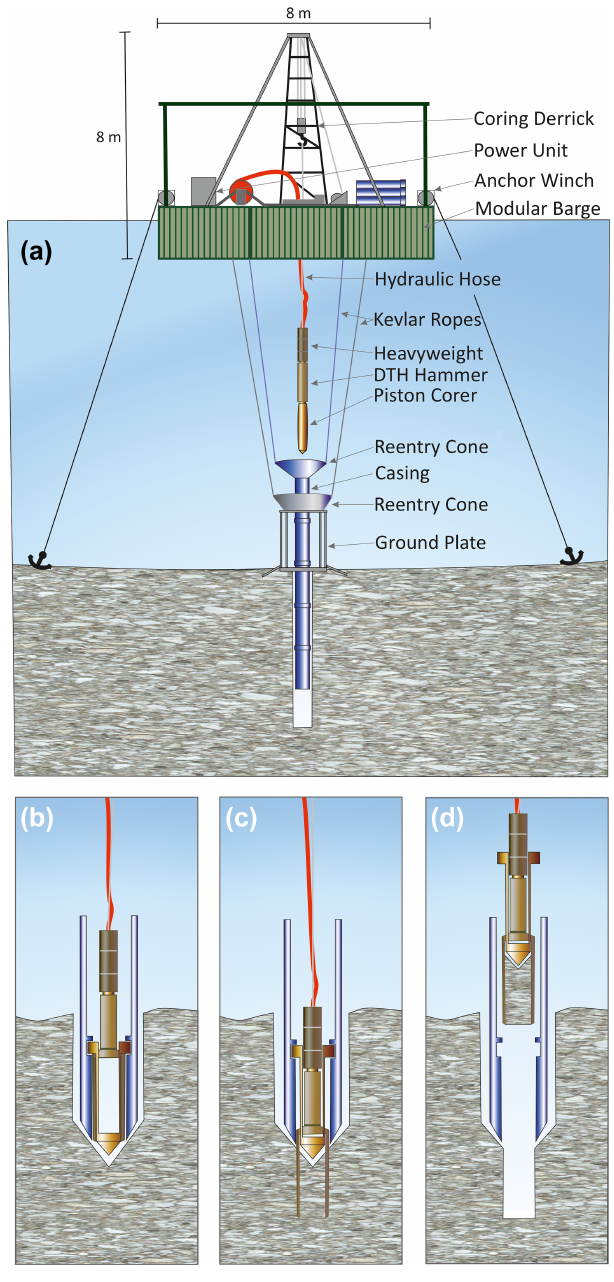
Figure 3. Scheme of Hipercorig key elements, with the ground plate set and coring assembly lowered half-way (a) . Illustration of coring operations with the coring assembly placed in the hole (b , the corer hammered into sediment (c) , and the extraction of coring assembly, including the new core, to the platform while the casing remains in place (d)